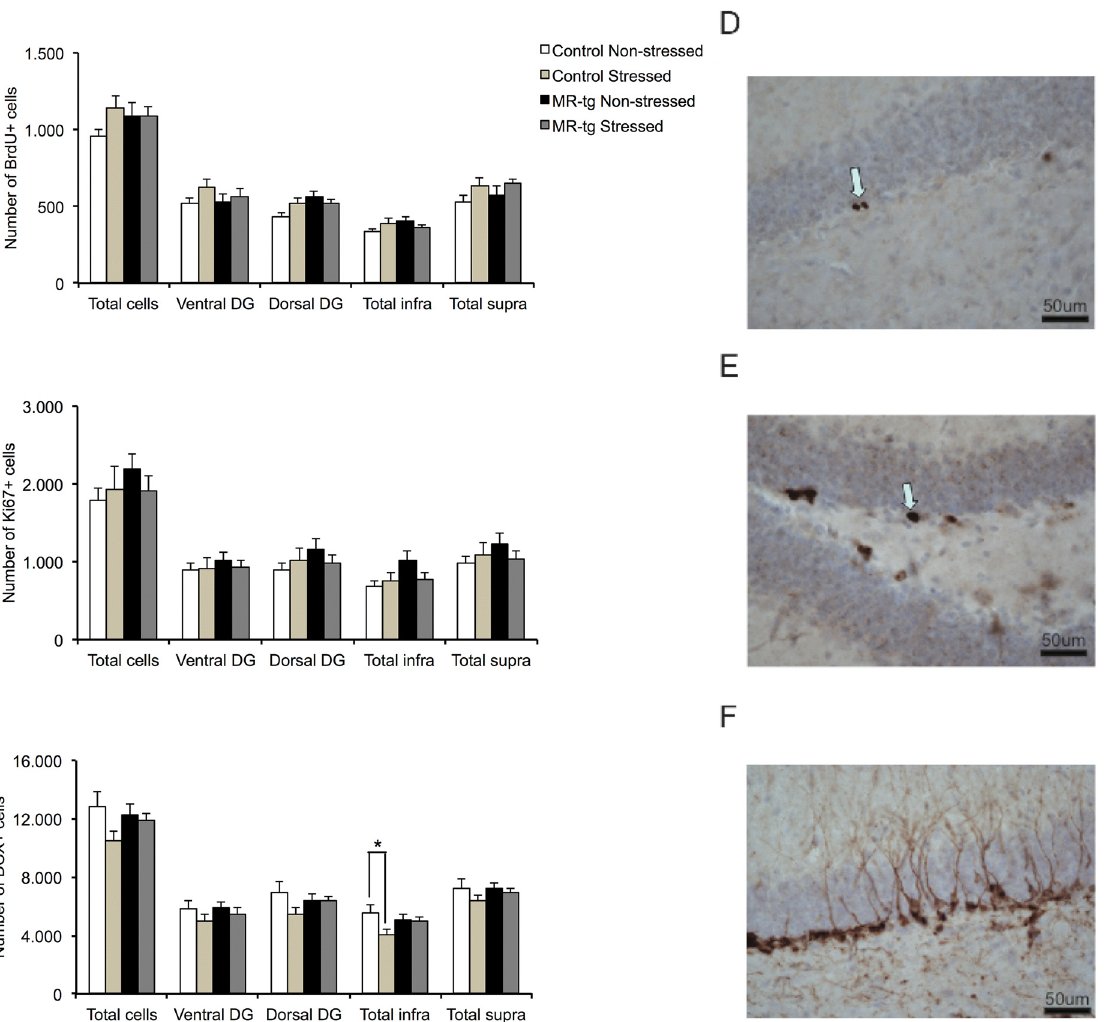
Fig 4. Neurogenesis results in stressed and non-stressed control and MR-Tg mice. Right panel shows representative examples of BrdU, Ki67 and DCX labeled cells being scored (D-F, arrows, calibration bar: 50 μ m). Left panel shows the bar graphs on the left summarize the averaged results for: (A) BrdU positive cells, (B) Ki67 positive cells and (C) DCX positive cells. For each marker we analyzed the total number of cells, the number of cells along the rostral and caudal subareas of the hippocampus as well as the numbers for two subregions that make up this total number (total infra and total supra). Data are expressed as mean ± SEM with p-values based on post-hoc LSD. n = 8 animals per group. * : significant, p (cid:1)